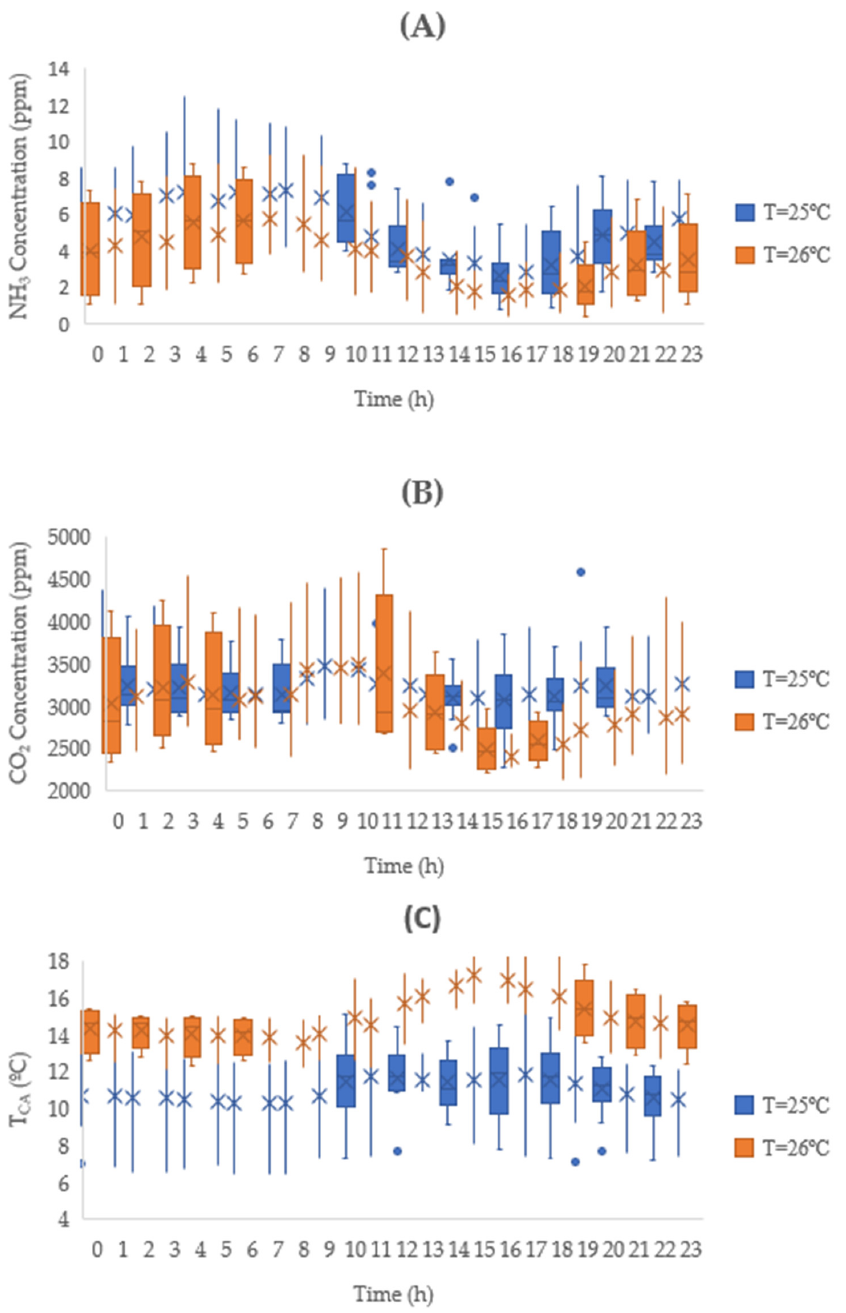
Figure 2. Evolution of hourly mean values, throughout the measuring period, of NH 3 concentration ( A ), CO 2 concentration ( B ) and temperature of air in external corridor ( C ) for each setpoint temperature.